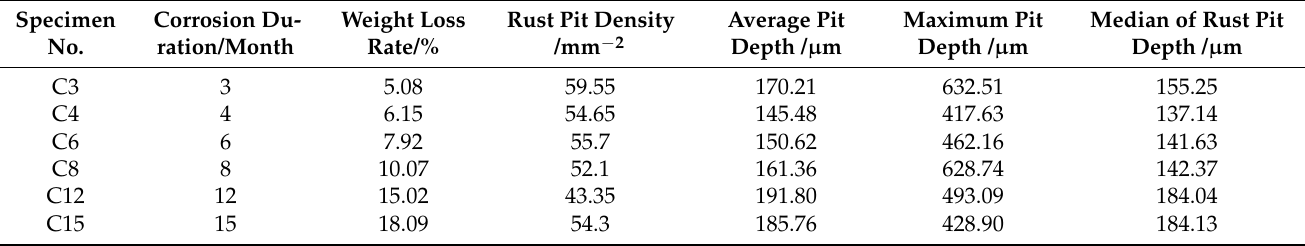
Table 1. Extraction results of pit density and depth for corroded steel plates with different corrosion